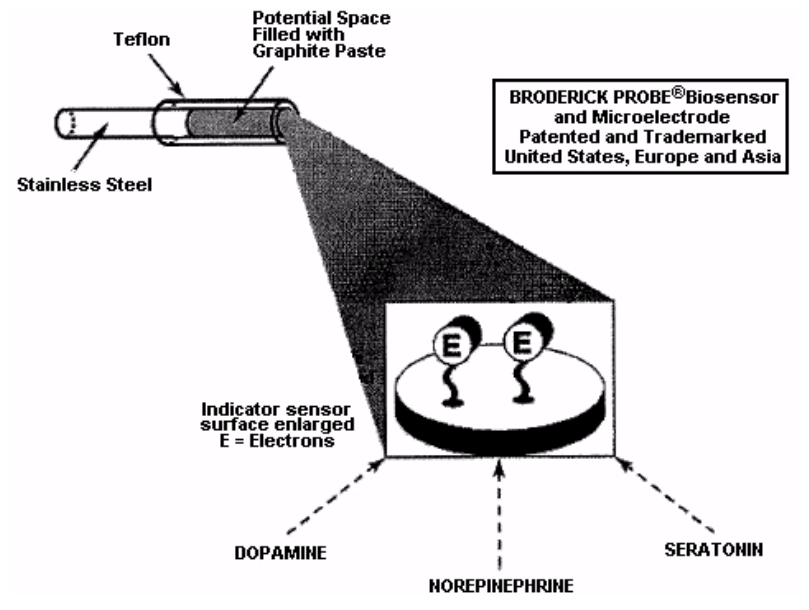
Figure 4. Diagram (Adapted, Broderick [49]) showing the electron transfer mechanism